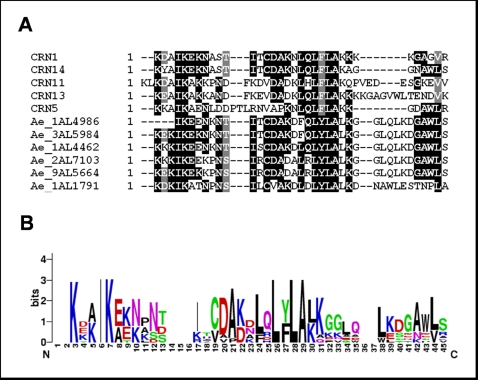
Identification of conserved amino acid residues at the N-terminal extremities of P. infestans and A. euteiches CRN sequences.A, multiple alignment of A. euteiches like CRNs and P. infestans CRNs (CRN1, CRN5, CRN11, CRN14) showing the highest homology to A. euteiches sequences. B, consensus sequence pattern calculated using Weblogo showing the most conserved amino acid residues.